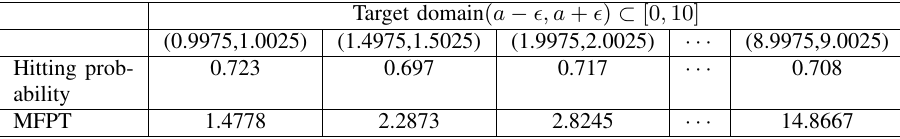
The hitting probability and the MFPT depending on the position of the target domain.